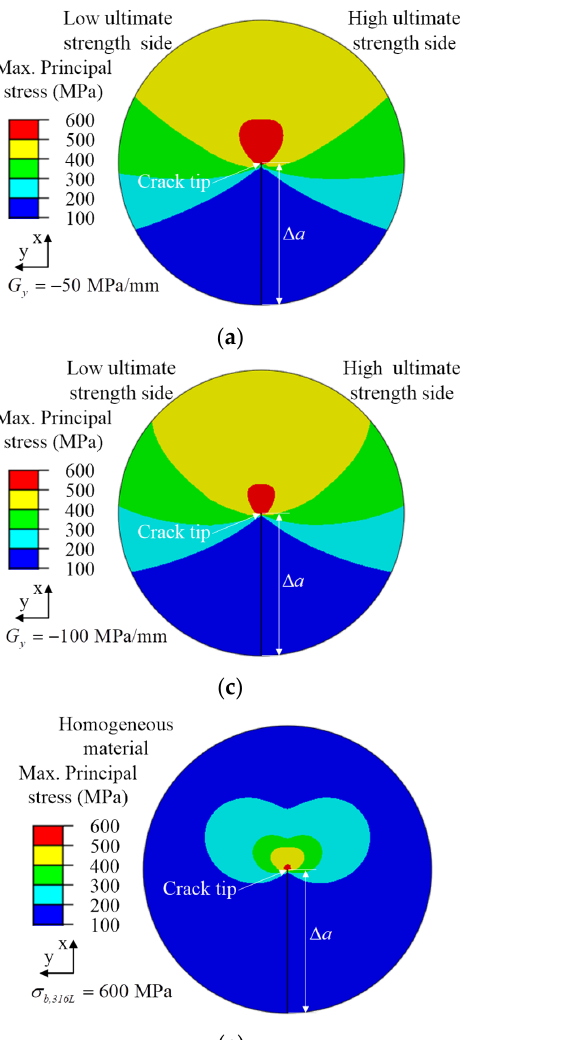
( b ) Figure 7. Fracture toughness during crack propagation with different ultimate strength mismatch coefficients in the y ‐ direction. ( a ) G y < 0 and ( b ) G y > 0.